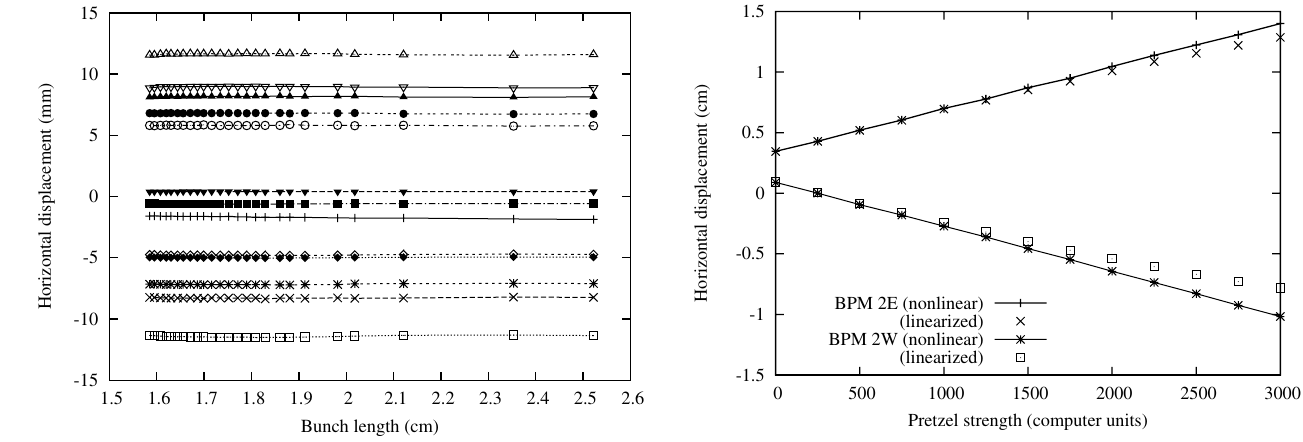
FIG. 5. Beam position at two detectors calculated with the nonlinear and linearized methods.